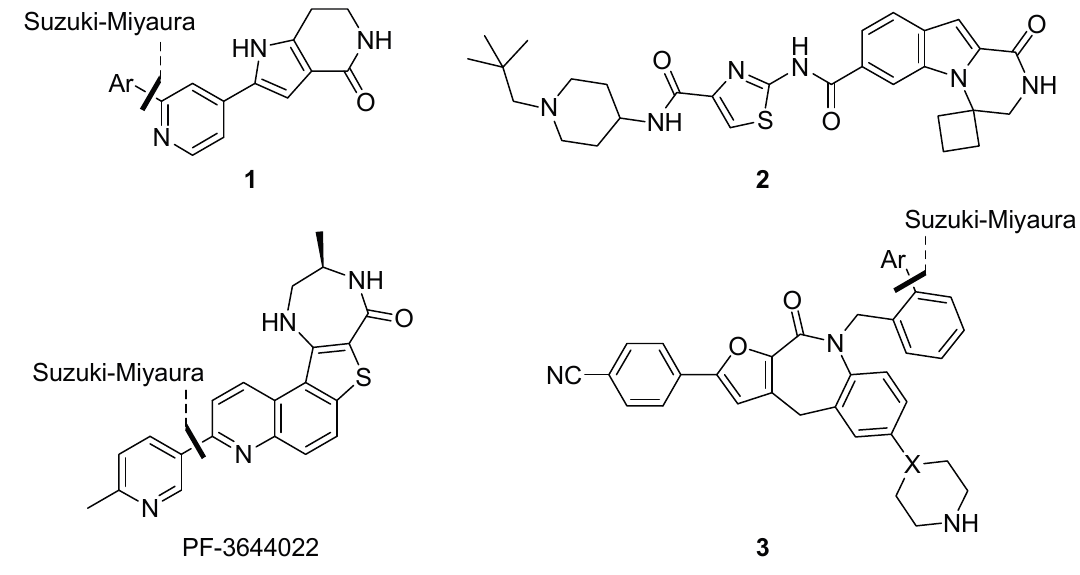
Figure 2. Examples of MK2 inhibitors from different drug discovery programs,